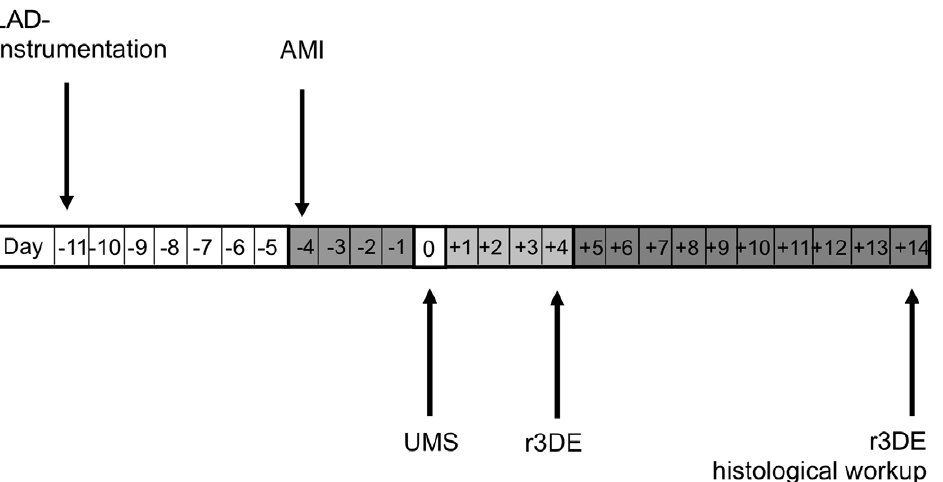
Figure 1. Experimental protocol. The instrumentive surgery of the left anterior descending coronary artery (LAD-Instrumentation) was performed seven days prior to the acute myocardial infarction and reperfusion (AMI/R) to avoid a pro-inflammatory influence of trauma on post-infarction remodelling (PIR). The treatment group received UMS four days after AMI/R. On day + 4 and + 14, a reconstructive 3-dimensional echocardiography (r3DE) was performed to quantify global and regional left-ventricular function. Additionally, r3DE was carried out with low-dose dobutamine on day + 14. Ultimately, hearts were harvested for histological workup.